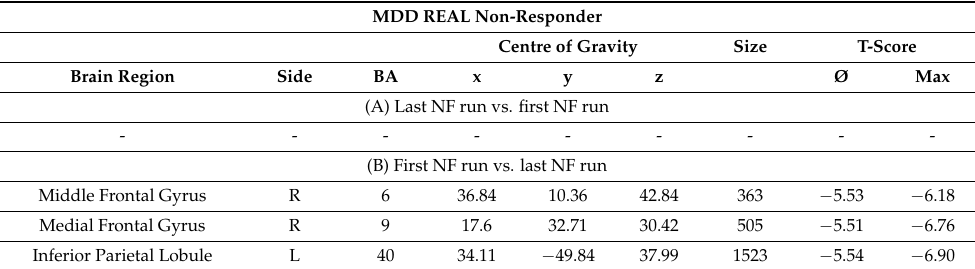
Table 9. Comparison of hemodynamic responses between the first and the last NF run in the MDD REAL Non-Responder group (negative emotion-associated pictures minus neutral pictures; clusters of >30 voxels, q (FDR) < 0.001, T-score: 8 to − 8). MDD REAL Non-Responder Centre of Gravity